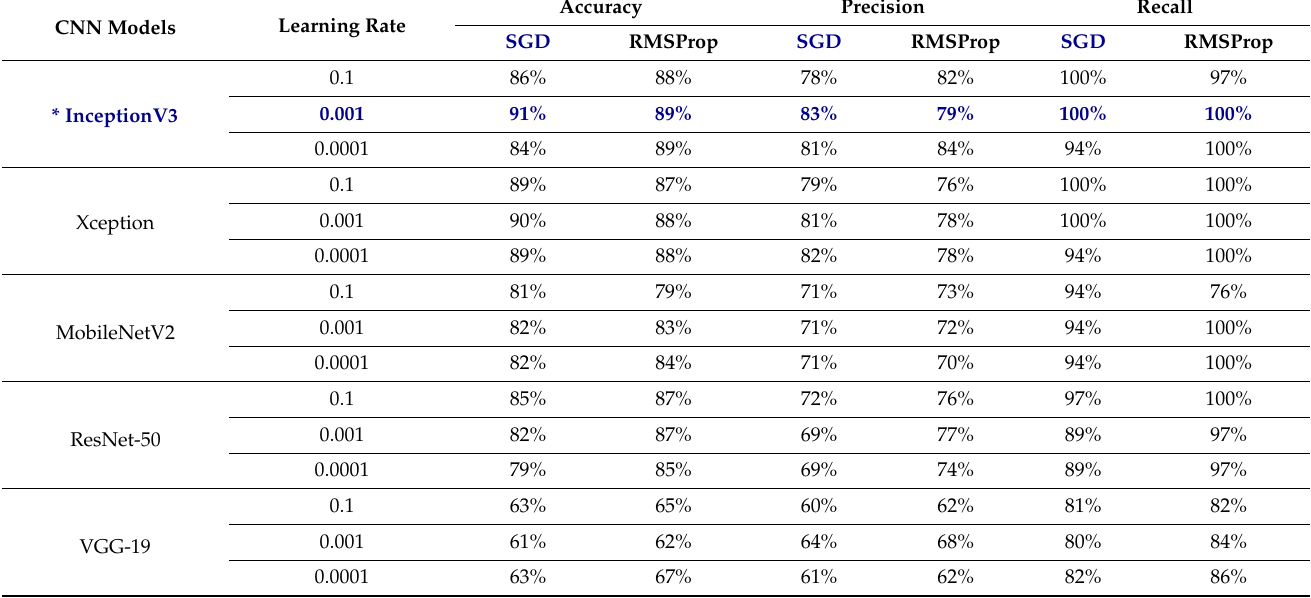
Table 4. Summary results of defects classification